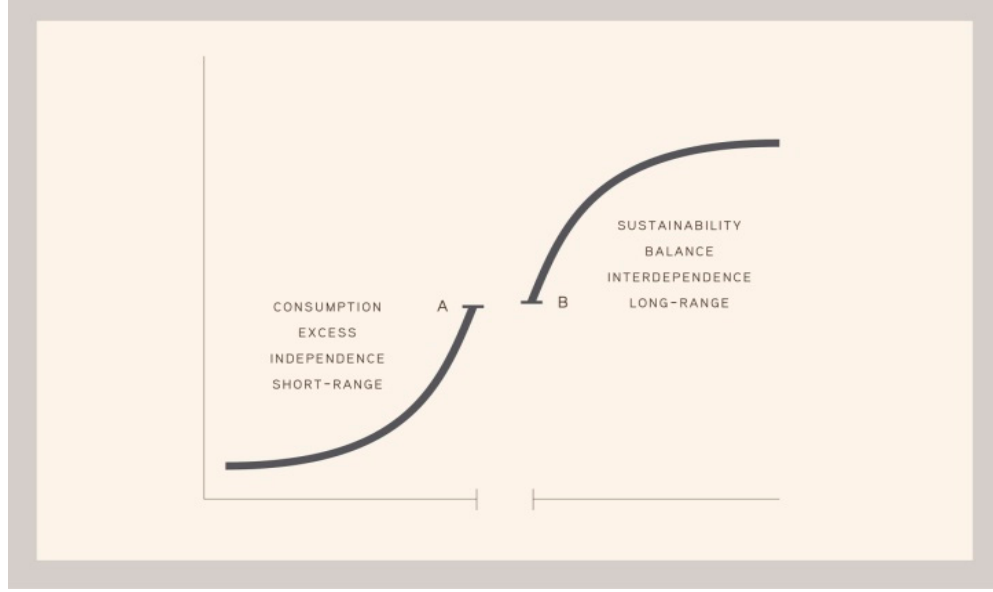
Figure 6. Shifting value systems with shifts in population dynamics. The attitudes, values, and behaviours that serve self-interest in Epoch A are very different from those that do so in Epoch B. Paradoxically, this means that in the reality of Epoch B, behaving in a more generous, community-oriented manner will better serve the interests of both individuals and groups than behaving in an exclusively self-oriented and competitive way. Therefore, collaboration, awareness of others, and balance will not be regarded as personal sacrifice. Instead, they will be personally and collectively beneficial.